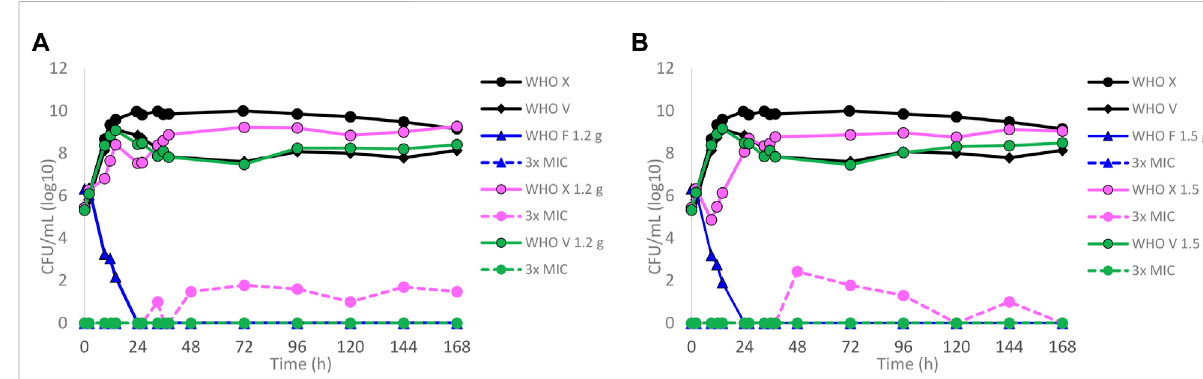
FIGURE 3 GrowthcurvesofthetotalpopulationofWHO Neisseriagonorrhoeae referencestrains(WHOF,X,andV)inhollow fi berinfectionmodel(HFIM) experiments simulating, based on free (12% protein-unbound) lefamulin concentrations in human plasma, (A) lefamulin oral daily dose of 1.2 g administeredasequallydivideddosesq12hfor7 daysand (B) lefamulinoraldailydoseof1.5 gadministeredasequallydivideddosesq12hfor7 days. All experiments were followed for 7 days. The total growth of the untreated controls (black solid lines) and total growth of lefamulin-resistant populations (dashed lines) on the lefamulin-containing plates (3 ×MIC) are also shown for each